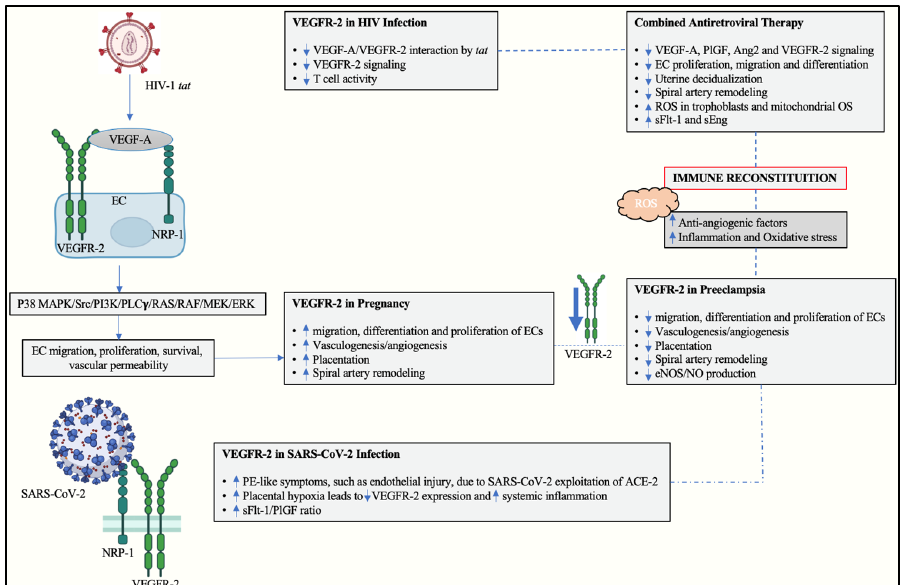
Figure 2. VEGFR-2 regulation in PE, HIV and COVID-19. Abbreviations: vascular endothelial growth factor receptor-2 (VEGFR-2), vascular endothelial growth factor-A (VEGF-A), neuropilin-1 (NRP-1), Severe Acute Respiratory Syndrome Coronavirus 2 (SARS-CoV-2), Angiotensin convert- ing enzyme-2 (ACE-2), Soluble fms-like tyrosine kinase-1 (sFlt-1), placental growth factor (PlGF), angiotensin-2 (Ang-2), Reactive Oxygen Species (ROS), oxidative stress (OS), endothelial cell (EC), Mitogen-activated protein kinase (MAPK), phospholipase-C γ (PLC γ ), protein kinase C (PKC), Rat sarcoma virus (RAS), Rapidly Accelerated Fibrosarcoma (RAF), Extracellular-signal-regulated kinase (ERK), Phosphoinositide-3 kinase (PI3K), protein kinase B (Akt), endothelial nitric oxide synthase (eNOS), nitric oxide